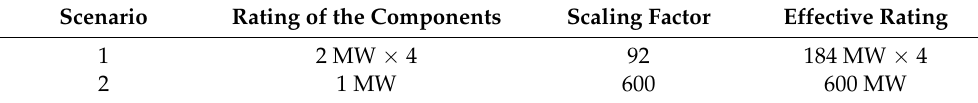
Table 1. Sizing and scaling up of the electrolyser system in the two proposed scenarios.